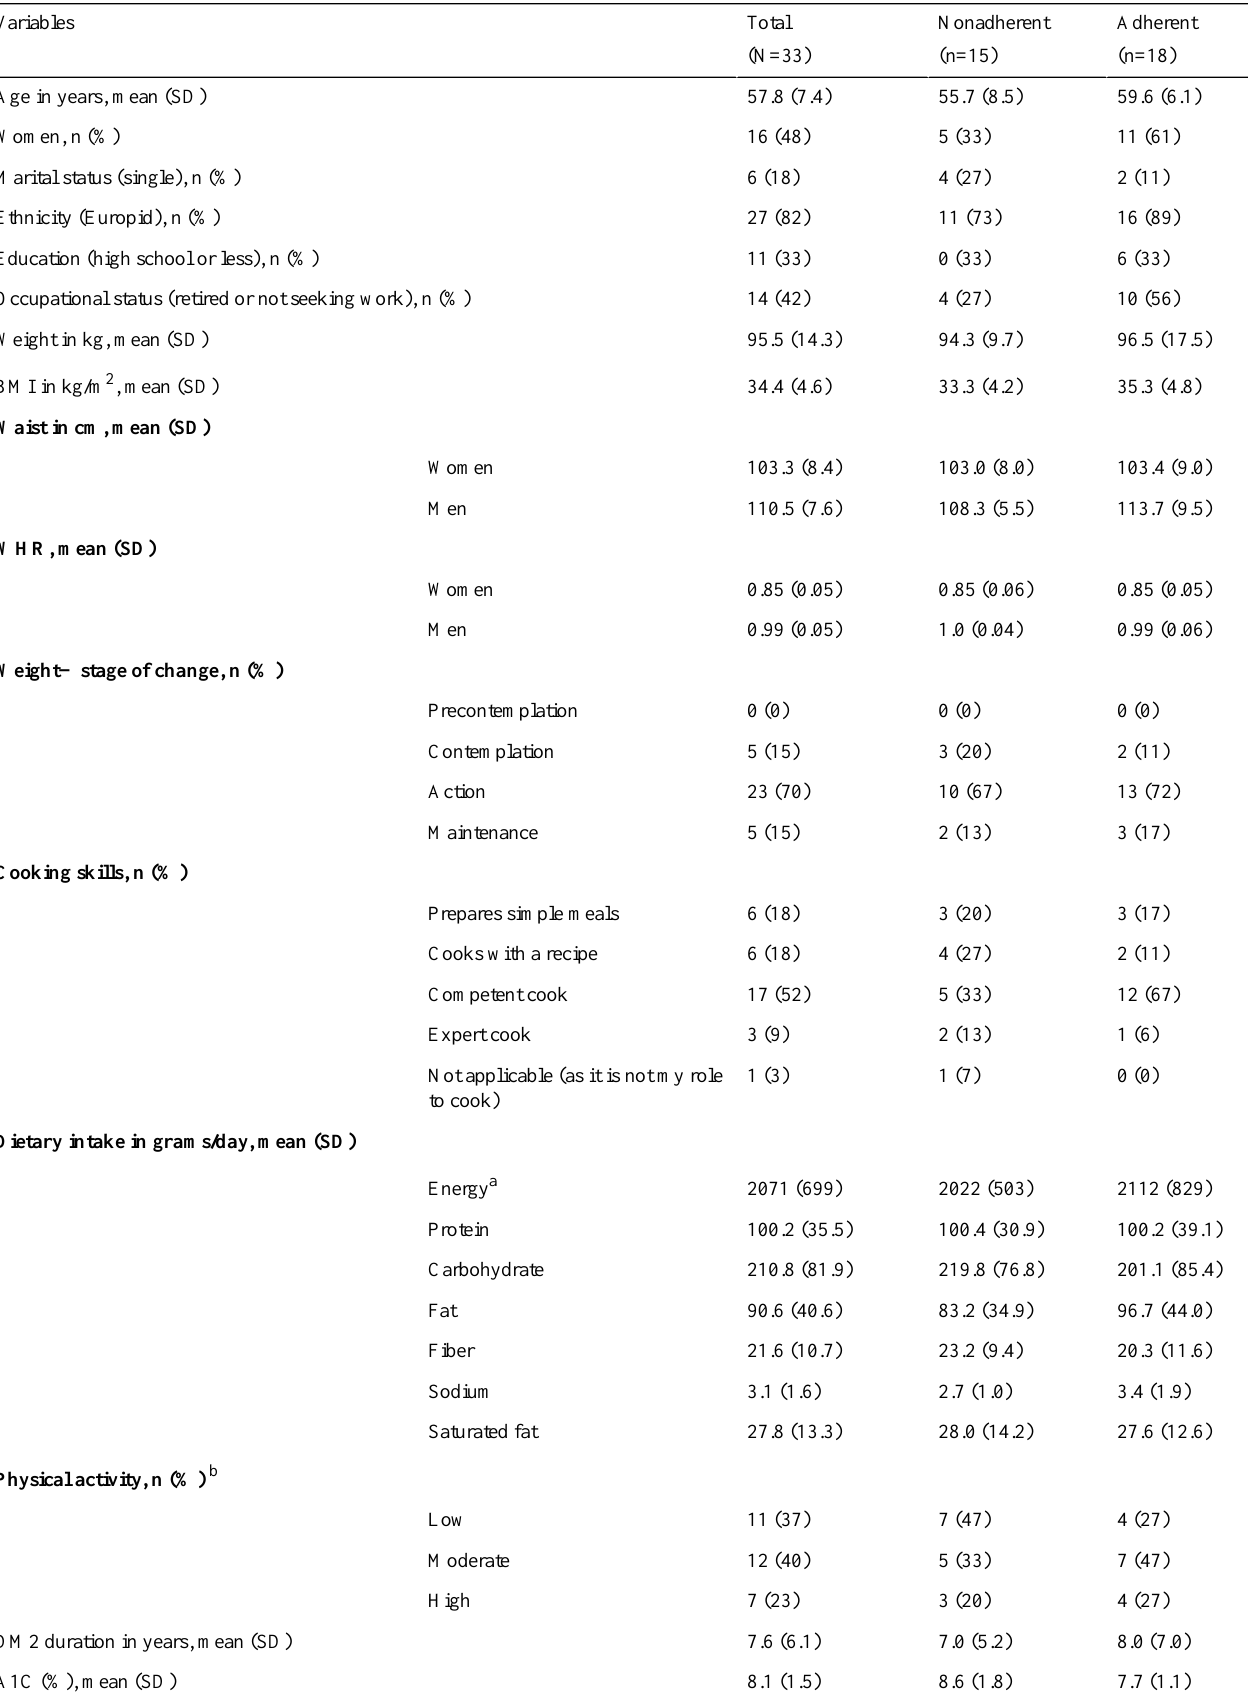
Table 1. Baseline characteristics, both overall and stratified by